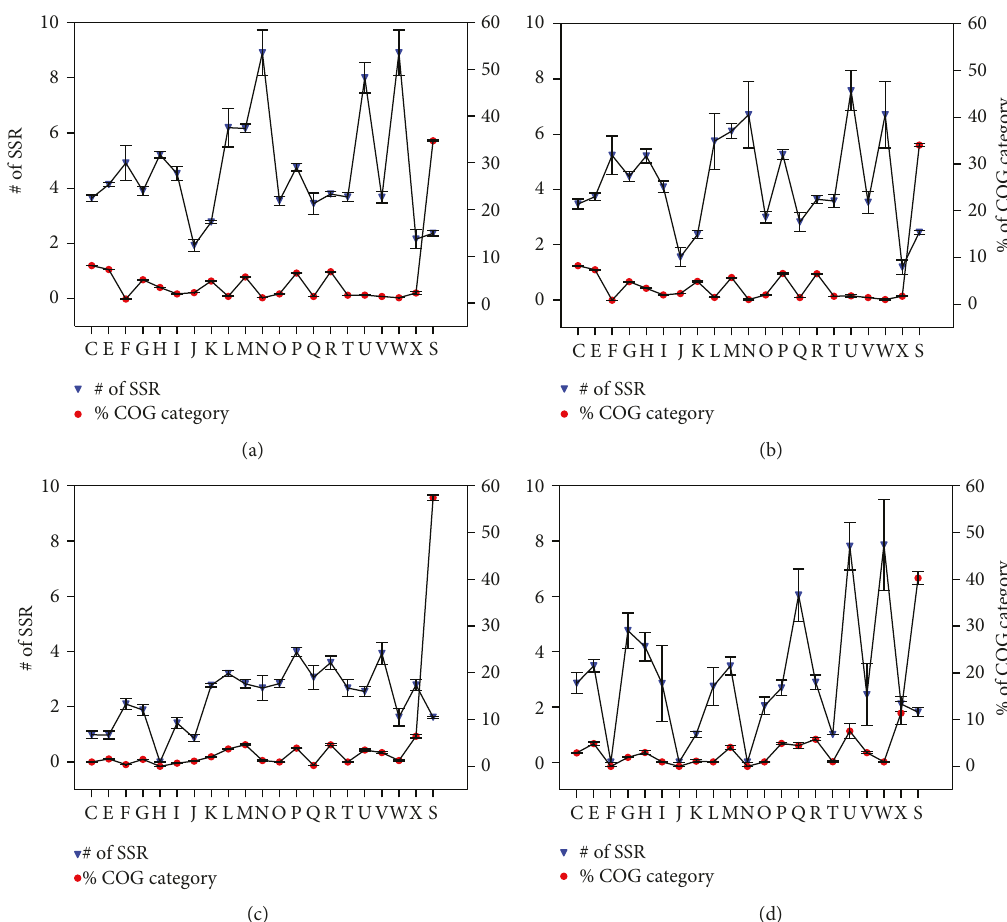
Figure 6: COG enrichment analysis of SSR loci in NMS and NGS unique genes. Subplots (a) and (b) represent the UGNP gene set characteristics based on Neisseria gonorrhoeae and Neisseria meningitidis datasets, respectively. Subplot (c) represents the UGNGS gene set characteristics based on 15 Neisseria gonorrhoeae strains, and subplot (d) represents the UGNMS gene set characteristics based on Neisseria meningitidis strains. The red circular markers represent the average percentage of genes that enriched in the COG function categories (C – X) for each genome dataset. The blue inverted triangle markers represent the average number of SSR of each COG category gene for each genome dataset. The error bar represents the standard error of the mean for each gene group. Since the gene is absent from fi ve COG categories (A, B, D, Y, and Z) in presented dataset, they have been omitted from the fi gures. Besides, the genes unassigned to any COG categories were combined into category S (function unknown). COG abbreviations: C: energy production and conversion;